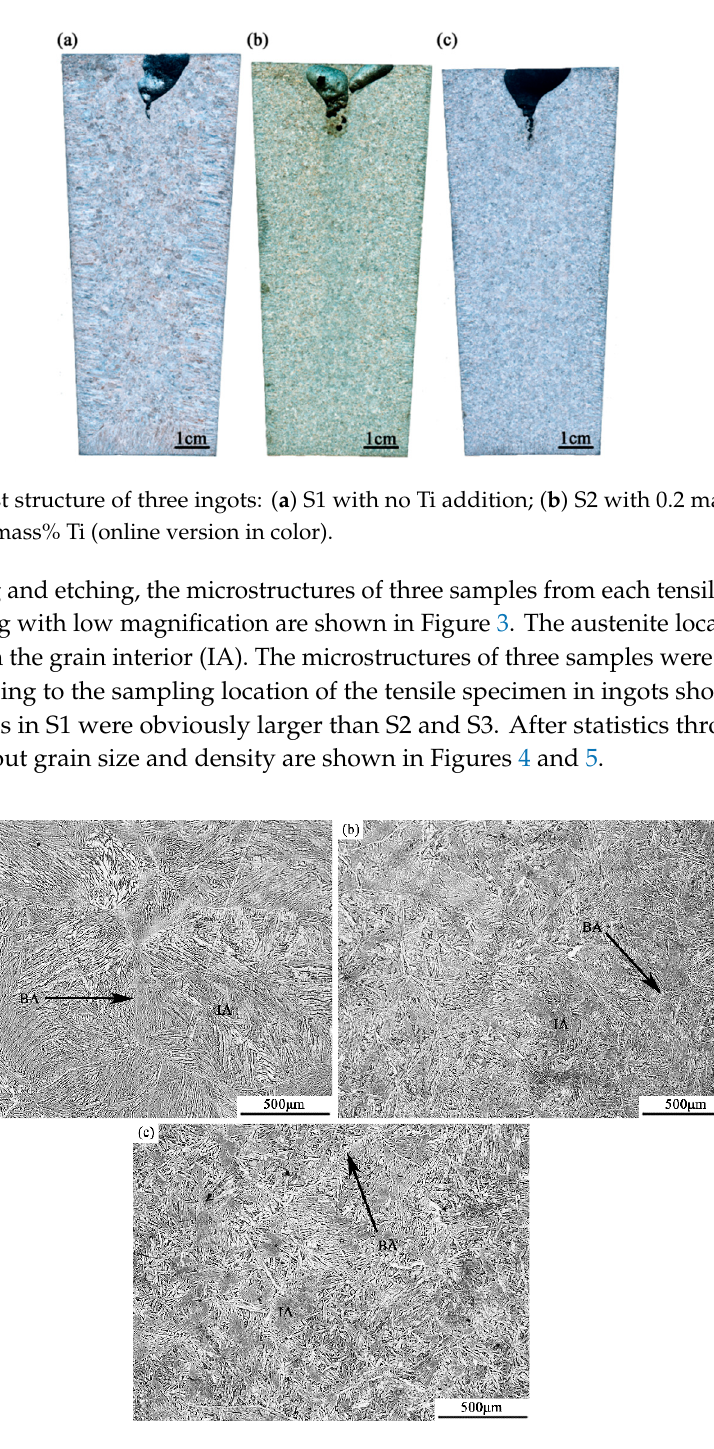
Figure 3. Microstructure of three samples with low magnification: ( a ) S1; ( b ) S2; and ( c ) S3.